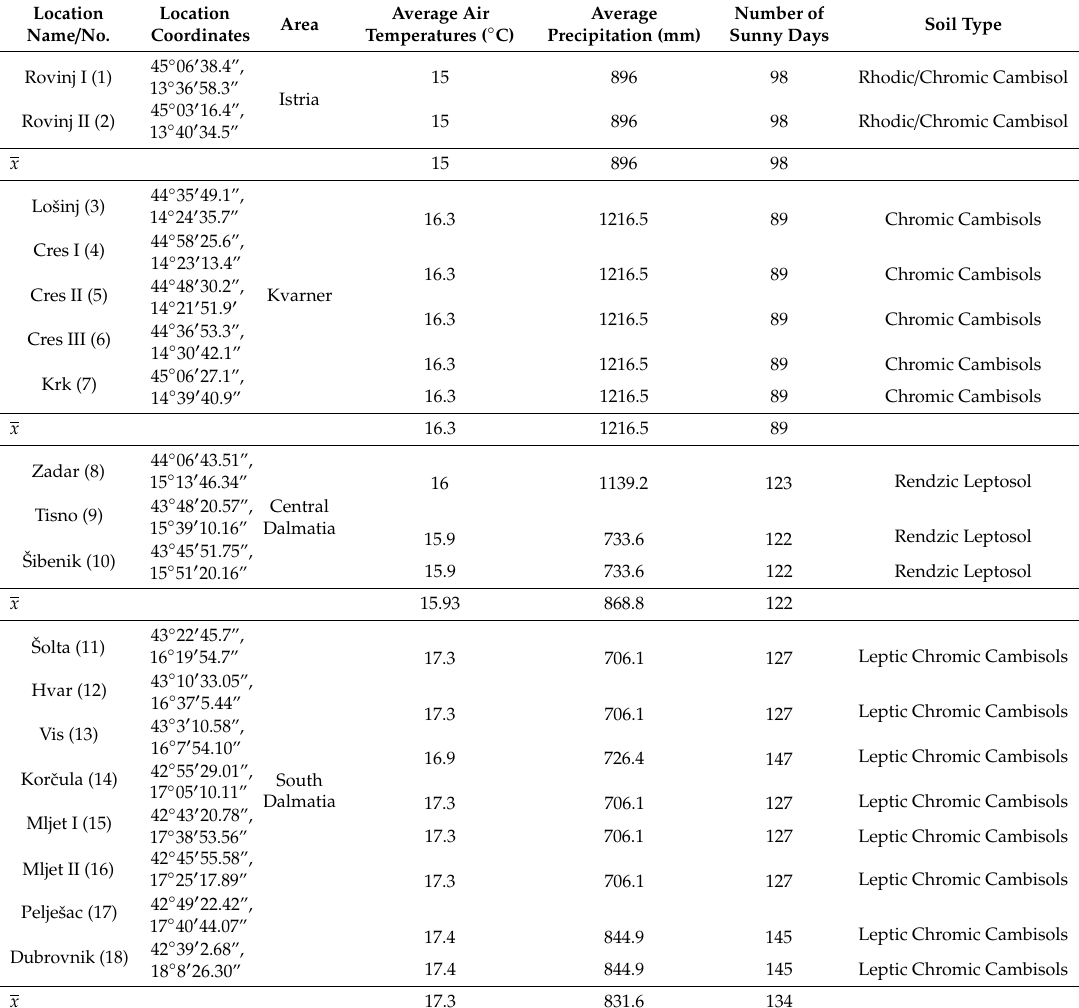
Table 5. Location geographical coordinates, meteorological data [16] and soil type [43] of collected wild strawberry tree populations within the Adriatic coast. Location Name /